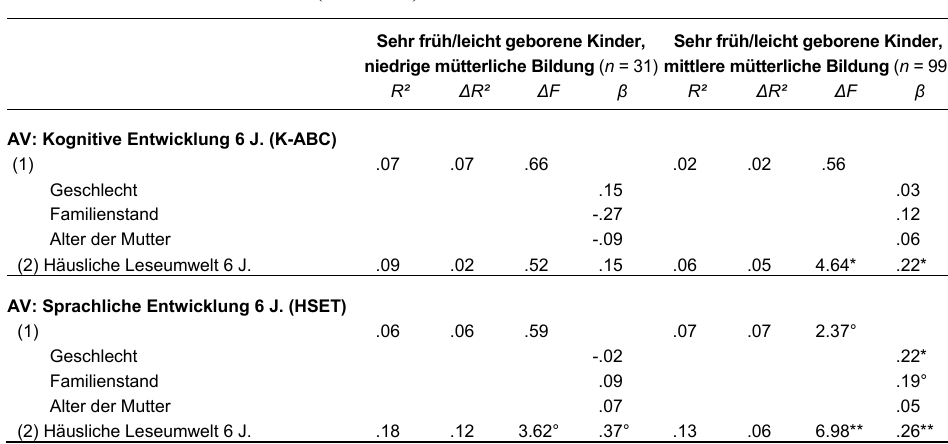
Tabelle 2 : Regressionsanalysen für den Einfluss der häuslichen Leseumwelt (Schritt 2) auf die kognitive und sprachliche Entwicklung sehr früh und/oder sehr leicht geborener Vorschulkinder, kontrolliert für Geschlecht, Familienstand und Alter der Mutter (Schritt